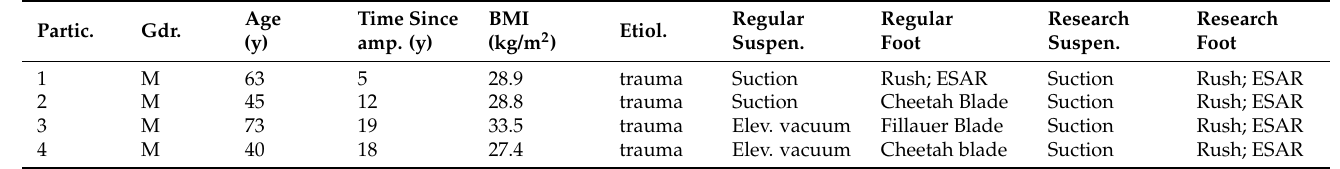
Table 1. Participant demographics information and prosthesis